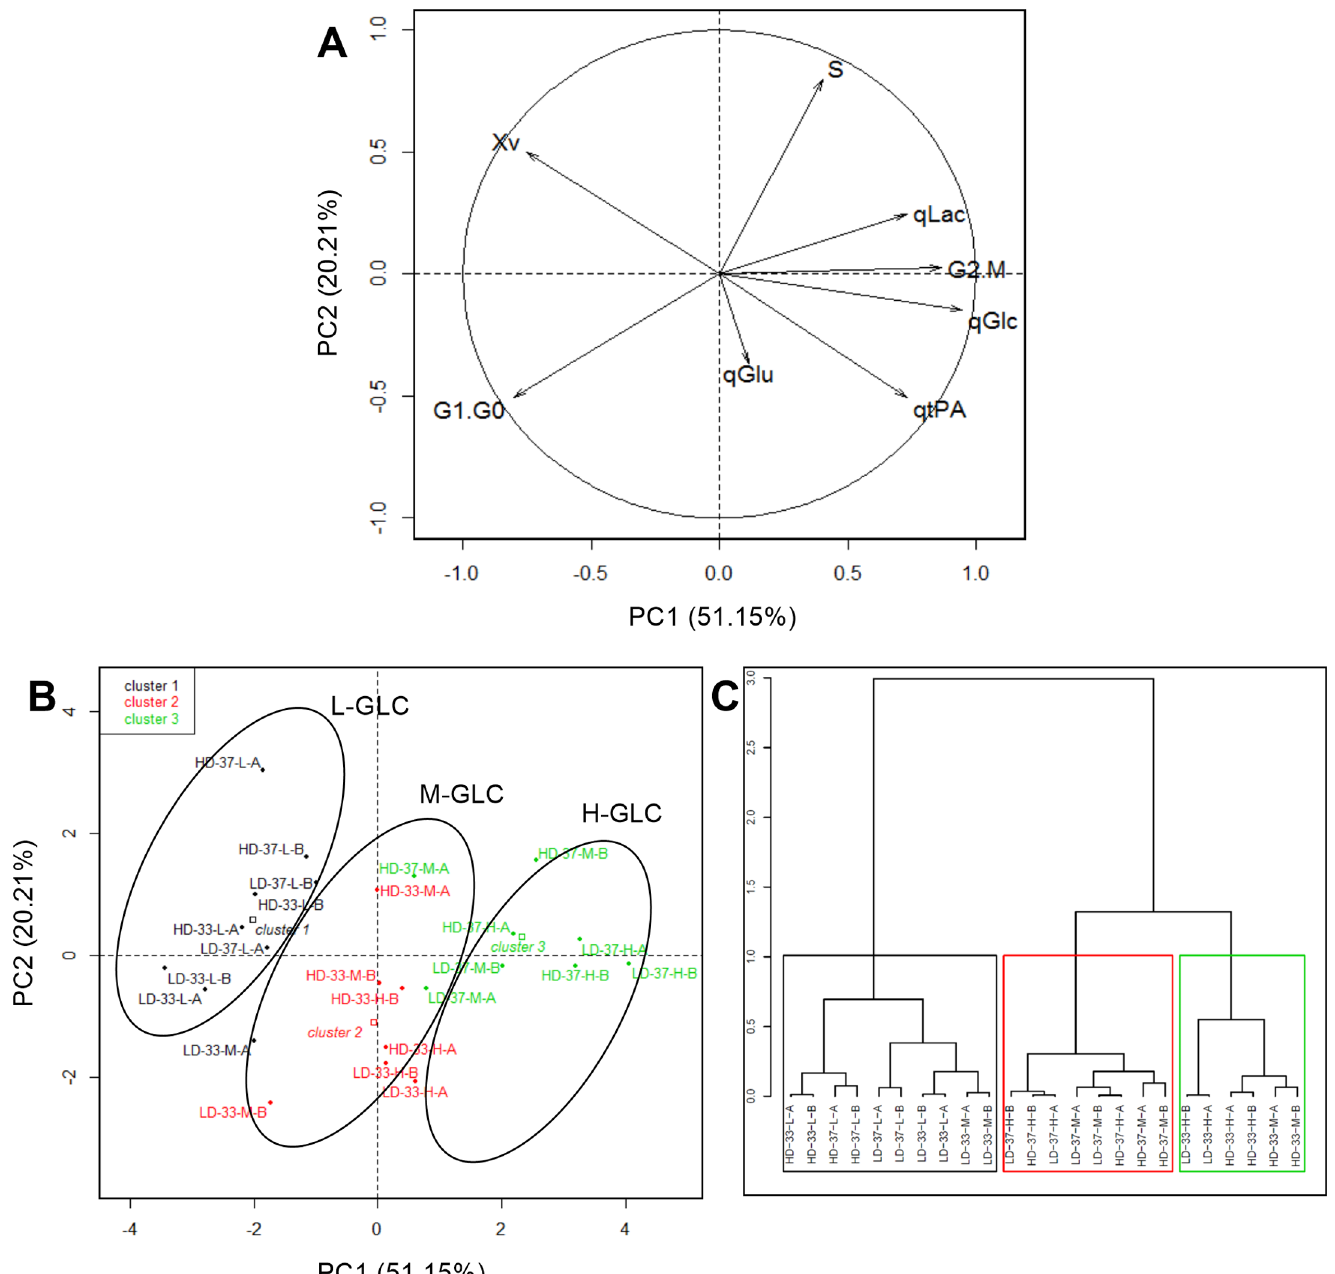
Fig 4. Principal component analysis (PCA) calculated using 10 physiological parameters of the 24 chemostat culture experiments. A corresponds to the ordination of parameters and correlation circle. B corresponds to the position of observations in the ordination where conditions of feed glucose concentration (i.e. H, M and L), dilution rate (i.e. HD and LD), temperature (i.e. 37 and 33) and each biological replicate (i.e. A and B) are represented, showing the effect of feed glucose concentration with circles. C corresponds to a hierarchical classification tree based on principal components and the different clusters evaluated using 1000 iterations. Xv: viable cell concentration; qGlu: specific glucose consumption; qLac: specific lactate production; Ylac: glucose on lactate yield; qGlu: specific glutamate consumption; qtPA: specific rh -tPA production; G1.G0, S and G2.M: percentage of cells placed in the corresponding point of cell cycle. PCA and hierarchical classification were performed using the “FactoMineR” package